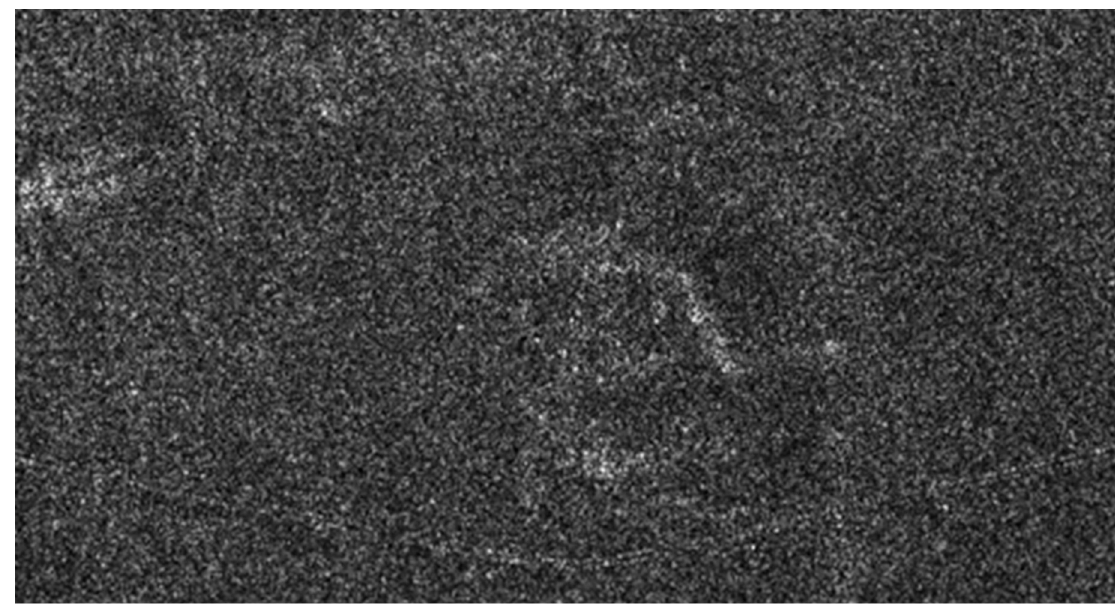
Figure 10. In a TerraSAR-X slant-range strip map HH image of the same cemetery, we can clearly